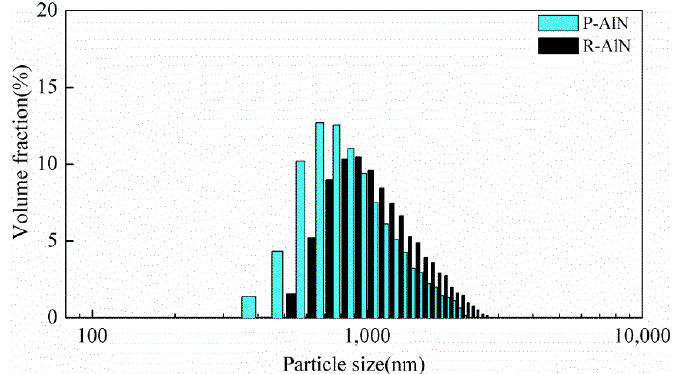
Figure 11. Particle size distribution diagram of AlN powder in water-based system.